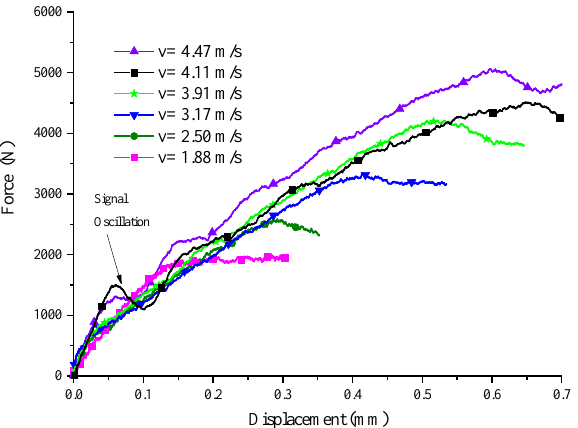
Figure 5. Force–displacement curve of 15° SCSs at different impact speeds.